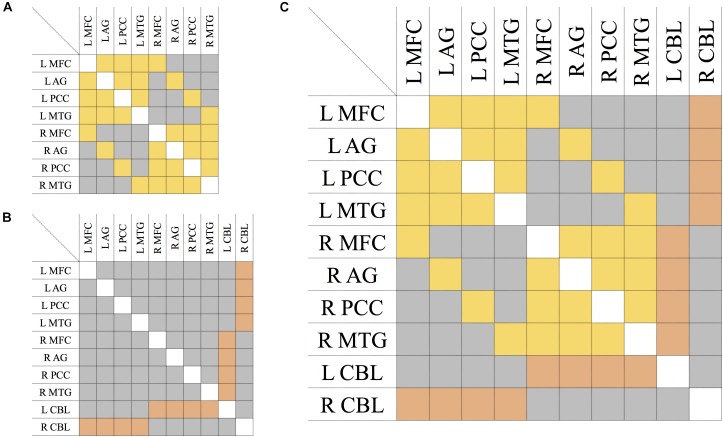
Connectivity matrix of the DMN (A), CBL (B), and CBL-DMN network (C). Symmetric entries of the matrix are shown in yellow and they represent bi-directional bundles of fibers linking network nodes like those tracts connecting DMN regions in the brain cortex. Asymmetric entries are shown in orange and they represent bundles of fibers where the signal is mono-directional like those tracts projecting from the cerebellum to the cerebral cortex. In gray are shown anatomically non-existent connections between nodes and existent connections which are neglected in a specific model, like connections between cortical regions in the model of the cortico-cerebellar loops (B); all of these are numerically represented by zero-elements. The elements along the principal diagonal that would represent self-connections are displayed in white. L/R = left/right. MFC, medial frontal cortex; AG, angular gyrus; PCC, precuneous/posterior cingulate cortex; MTG, middle temporal gyrus; CBL, cerebellum.